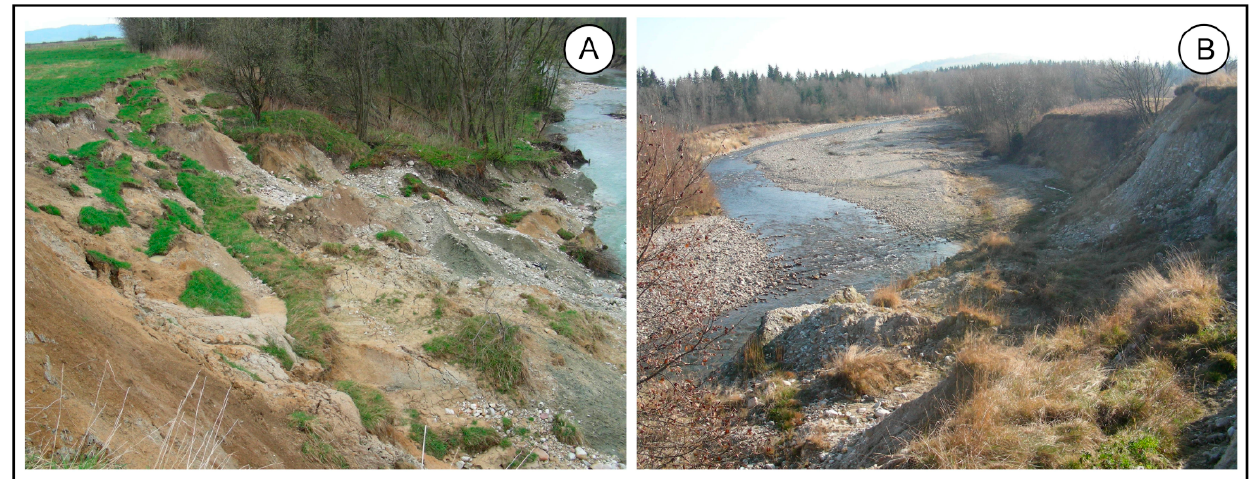
Figure 3. Chochoł ó w landslide (site 1) being undercut by the Czarny Dunajec River; ( A )—landslide relief; ( B )—location of the Czarny Dunajec River channel in reference to the landslide toe. At site 2 the Wielki Rogo ź nik River erodes colluvium, which is also matrix-sup- ported, and massive gravel and clays at the top slid off a 6–7 m high river terrace. The gravel is composed of highly weathered crystalline rocks and comes from a series 5–5.5 m